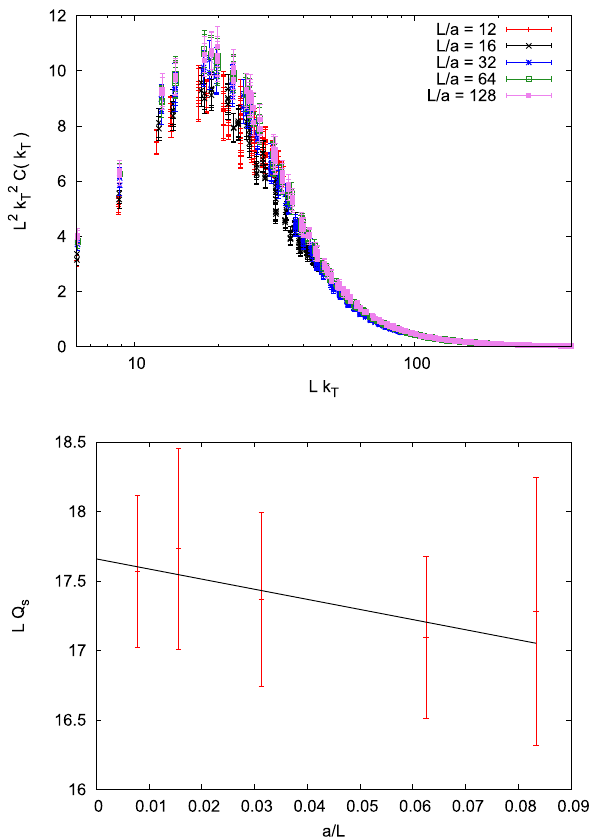
Fig. 6 Top: volume dependence of the momentum-space correlator from the initial condition. Bottom: dependence of the saturation scale on the lattice extent. Black line is the attempted infinite volume extrap- olation with f ( 1 / L ) = a + b / L . Clearly all the volumes are compatible with the extrapolated value, hence no finite volume effects are associ- ated with the initial condition at these values of the MV